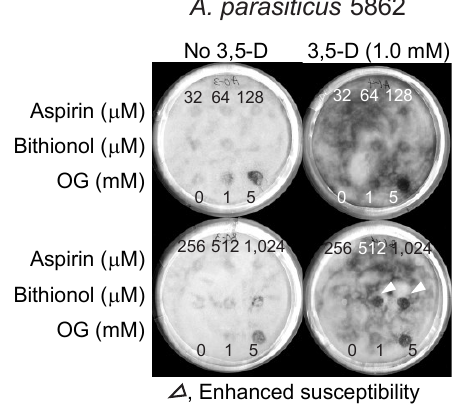
Figure 6. Enhancement of the antifungal activity of bithionol by 3,5-dimethoxybenzaldehyde tested in the aflatoxigenic A. parasiticus 5862. 3,5-D, 3,5-dimethoxybenzaldehyde; OG, octyl gallate (positive